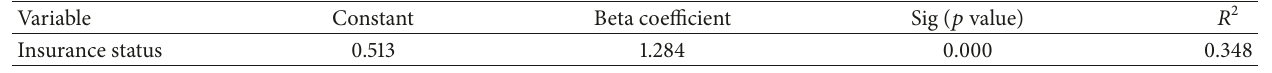
Table 3: Bivariate regression factor for influence of insurance status on use of